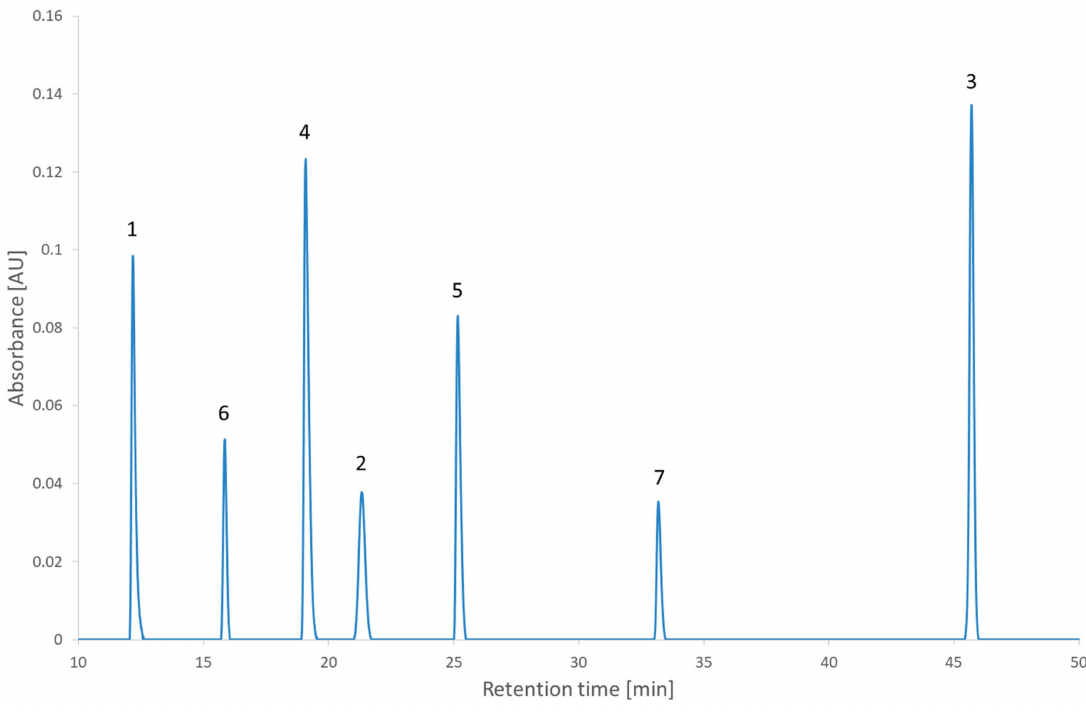
Figure 6. The chromatogram extracted at 210 nm of the second test set analyzed in the condi- tion of pH 2.7 and a gradient time of 54 min. 1: 2,2 (cid:48) -bipyridine, 2: 4-nitrophenol, 3: ibuprofen, 4: metoclopramide, 5: papaverine, 6: pindolol, 7: verapamil.